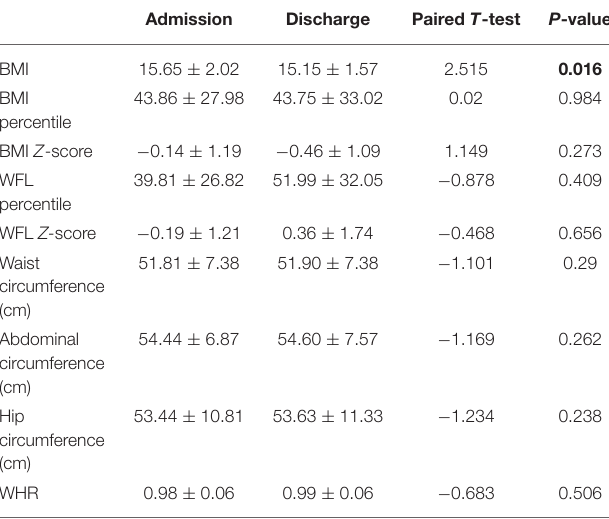
TABLE 3 | Patient physical characteristics at diagnosis and